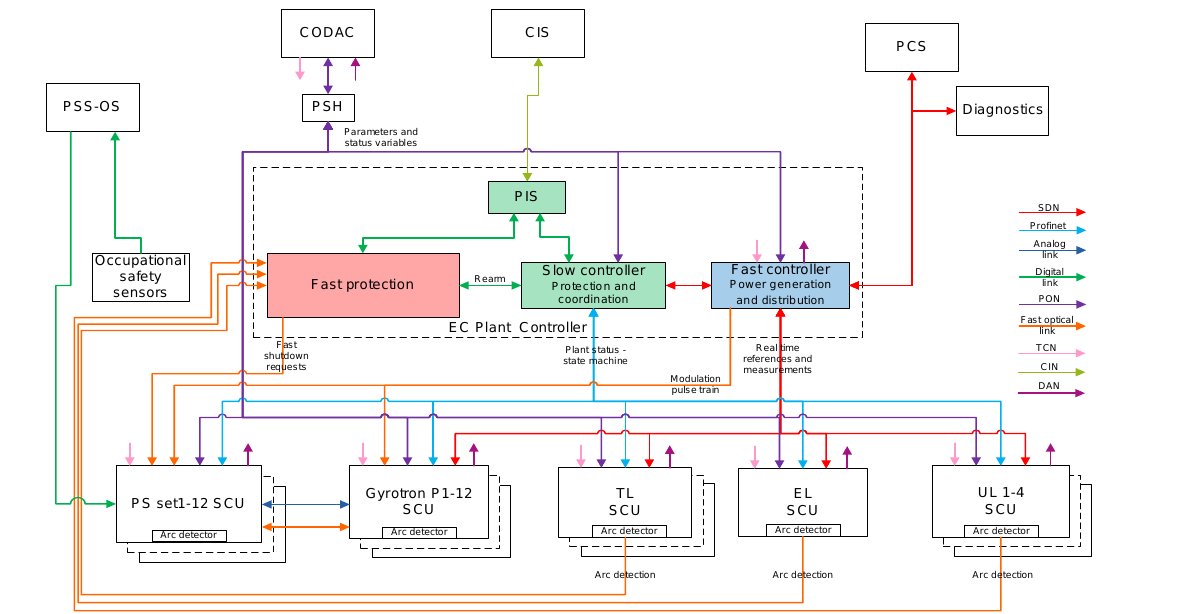
Fig. 7. EC control system